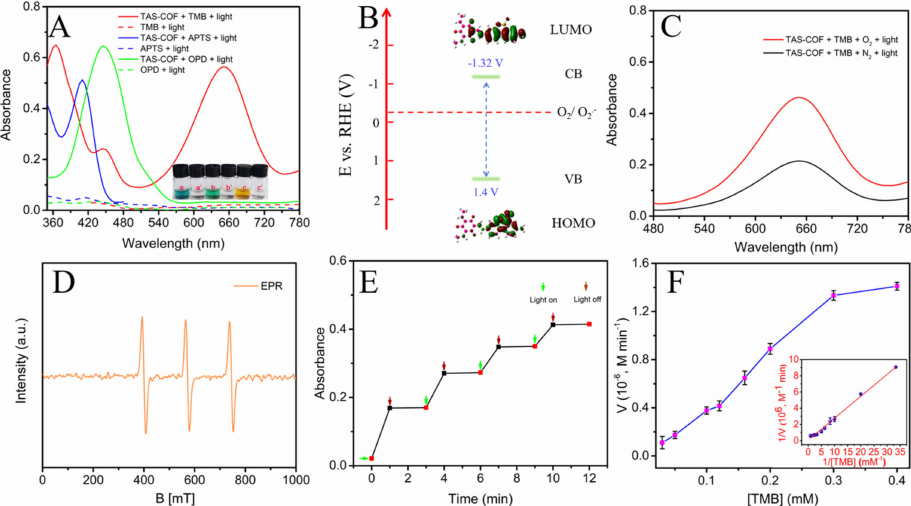
Figure 2. ( A ) UV-vis spectra of the system containing TMB, APTS, and OPD with/without TAS-COF in HAC-NaAc buffer (0.2 mol L − 1 ) under visible light irradiation. Insert: the images of the system containing TMB (a, a’), APTS (b, b’), and OPD (c, c’) ( B ) Band alignment of TAS-COF (Insert: the images of LUMO and HOMO). ( C ) UV-vis spectrum of TAS-COF + TMB + O 2 and TAS-COF + TMB + N 2 under visible light irradiation. ( D ) EPR spectra of TAS-COF after illumination using white-light LED lamp for 10 min. ( E ) Staircase-like response of the oxidase-mimicking activity to light irradiation. ( F ) Steady-state kinetic assays of TAS-COF by varying TMB concentrations. Inset: Lineweaver − Burk plots of the catalytic capacity of TAS-COF with TMB as the substrate. The error bars represent the standard deviation ( n =